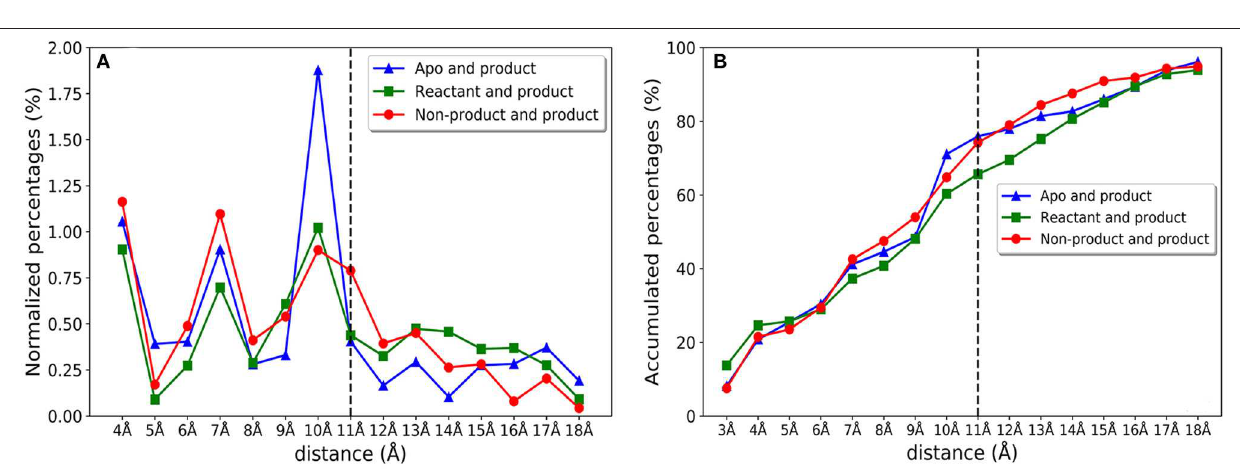
FIGURE 10 | The feature importance of residues with reference to the distance from active site for apo/product, reactant/product, and non-product/product classification models. (A) The normalized feature importance of residues within certain distance from active site (using 1 Å window). For example, the importance percentage 0.25% in 5 Å represents the importance percentage of all residues located in distance range 4–5 Å away from the active site; (B) Accumulative feature importance of residues with a certain distance from the active site. For example, the importance percentage of 5 Å represents the importance percentage including all the residues within 5 Å away from the active